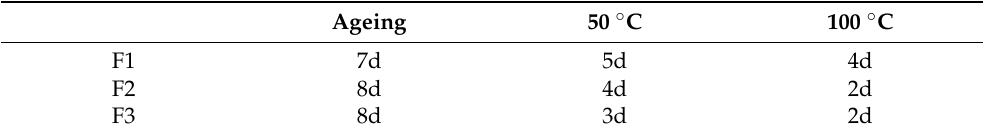
Table 4. Synthesis parameters for zeolites F1 to